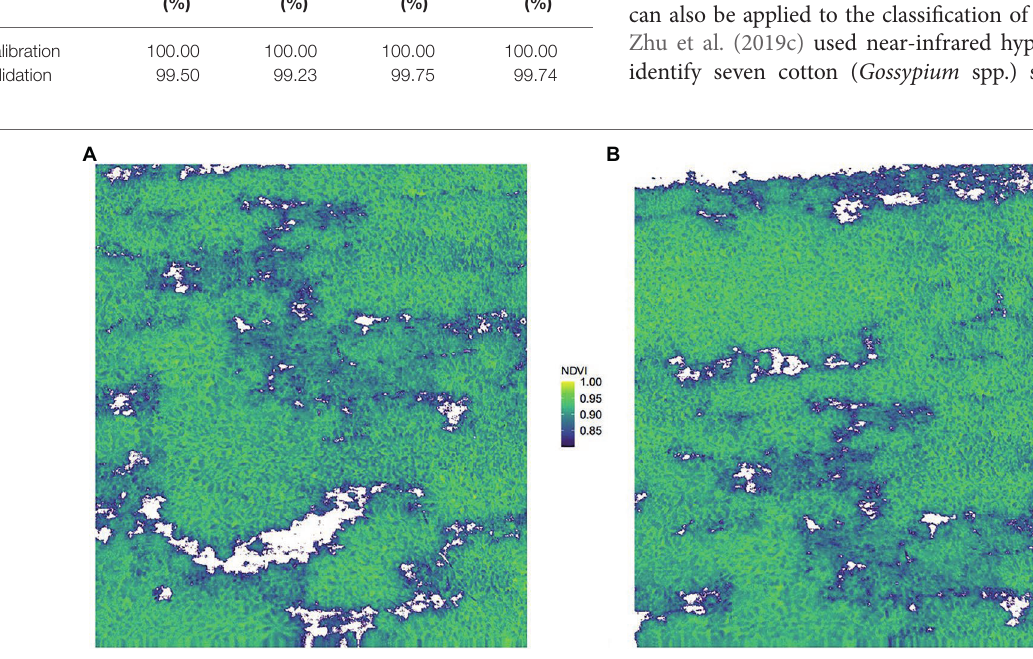
FIGURE 6 | Retained graphs with NDVI > 0.8. (A) Original image 1 after NDVI screening; (B) Original image 2 after NDVI